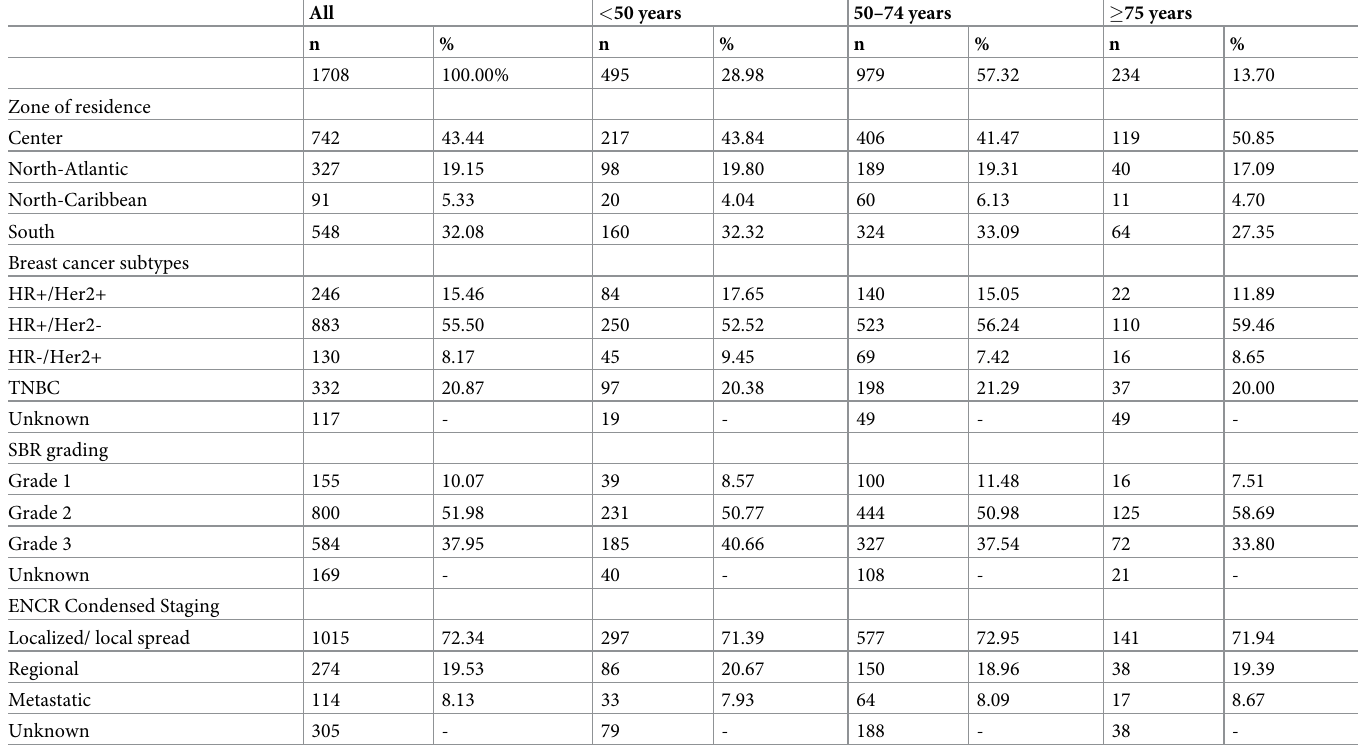
Table 1. Characteristics of breast cancer patients according to age group in Martinique,